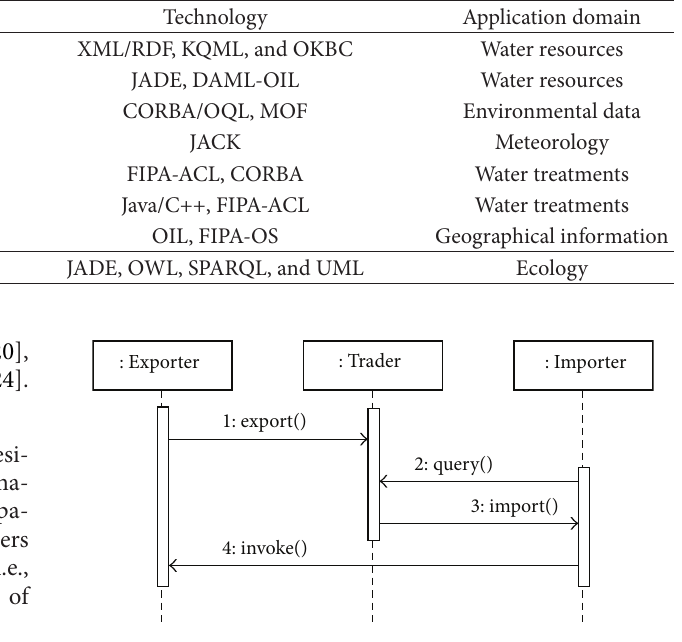
Figure 1: Roles of the ODP trader ( Adapted from ISO RM-ODP ).